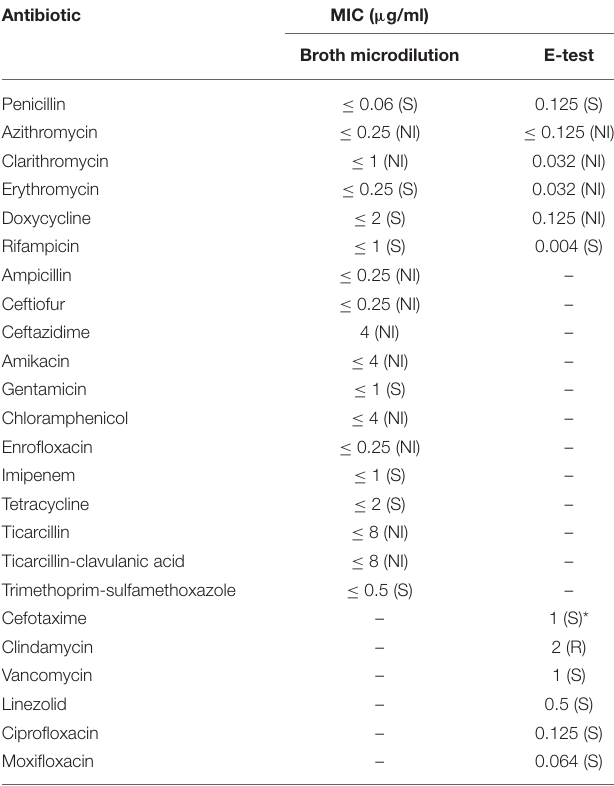
TABLE 1 | Antimicrobial susceptibility testing of C. ulcerans LIV-14050 isolate by broth dilution using a veterinary panel (EQUIN2F Vet AST Plate) and by E-test (ETEST ® , bioMérieux) against a human antimicrobial panel.